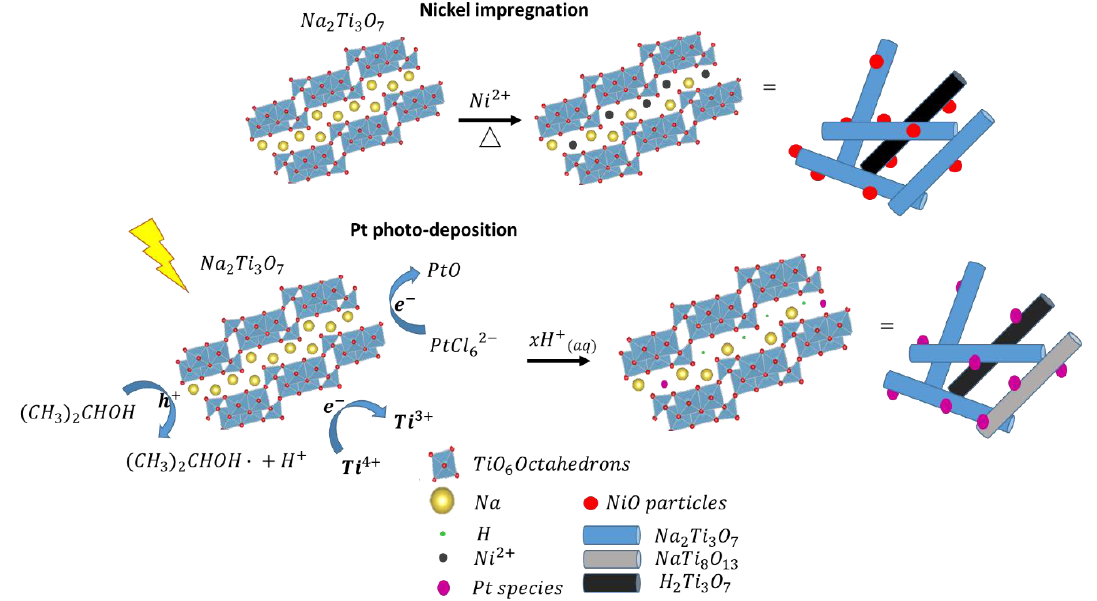
Figure 8. Proposed reaction mechanism of the phase transition during the Na 2 Ti 3 O 7 single Ni impregnation and Pt photo-deposition.